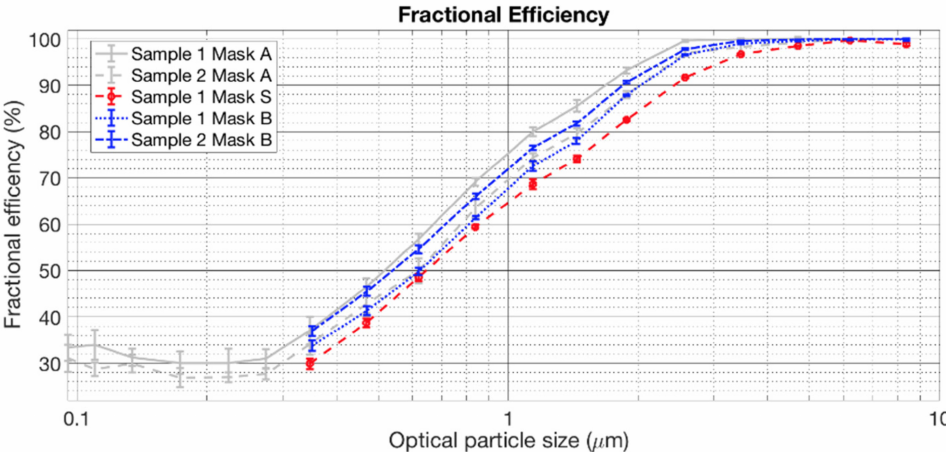
Figure 6. Fractional efficiency for each sample tested and for each